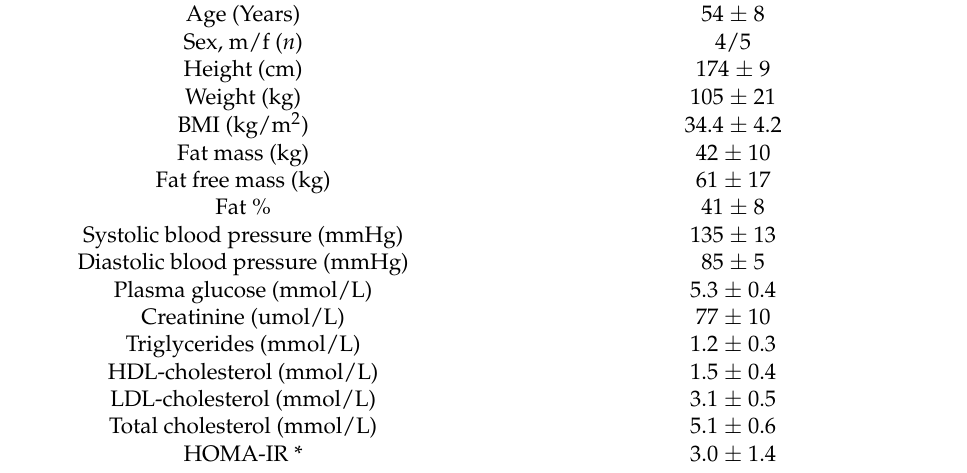
Table 1. Baseline characteristics ( n =